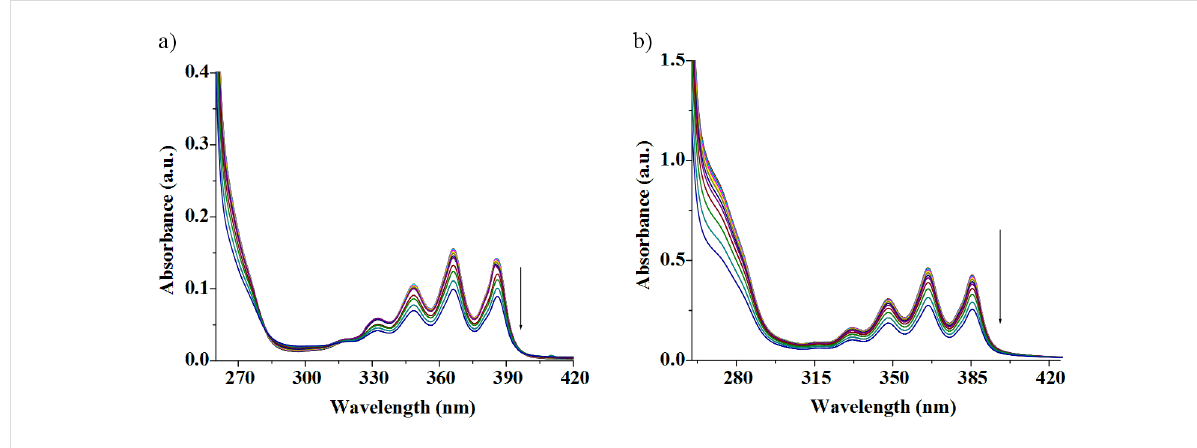
Figure 10: a) Absorption spectra of receptor 2 ( c = 1.48 × 10 − 5 M) upon gradual addition of Ag + ion ( c = 4.4 × 10 − 4 M) in CH 3 CN containing 0.1% DMSO; b) absorption spectra of receptor 1 ( c = 5.09 × 10 − 5 M) upon gradual addition of Ag + ion ( c = 1.4 × 10 − 3 M) in CH 3 CN containing 0.02%